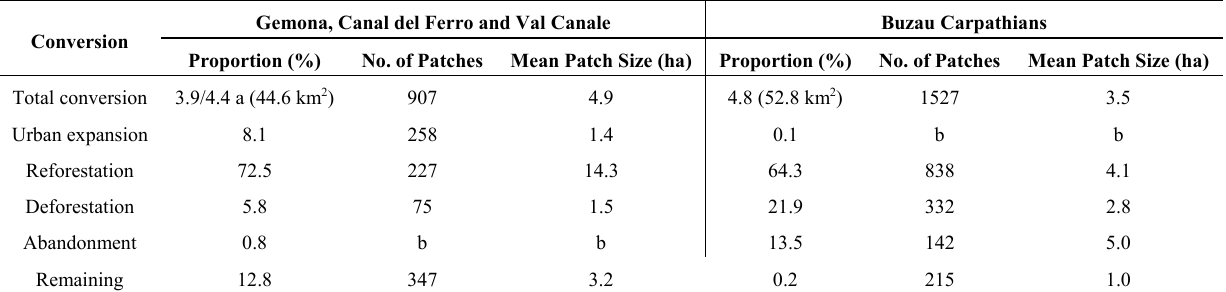
Table 5. Major land cover conversions